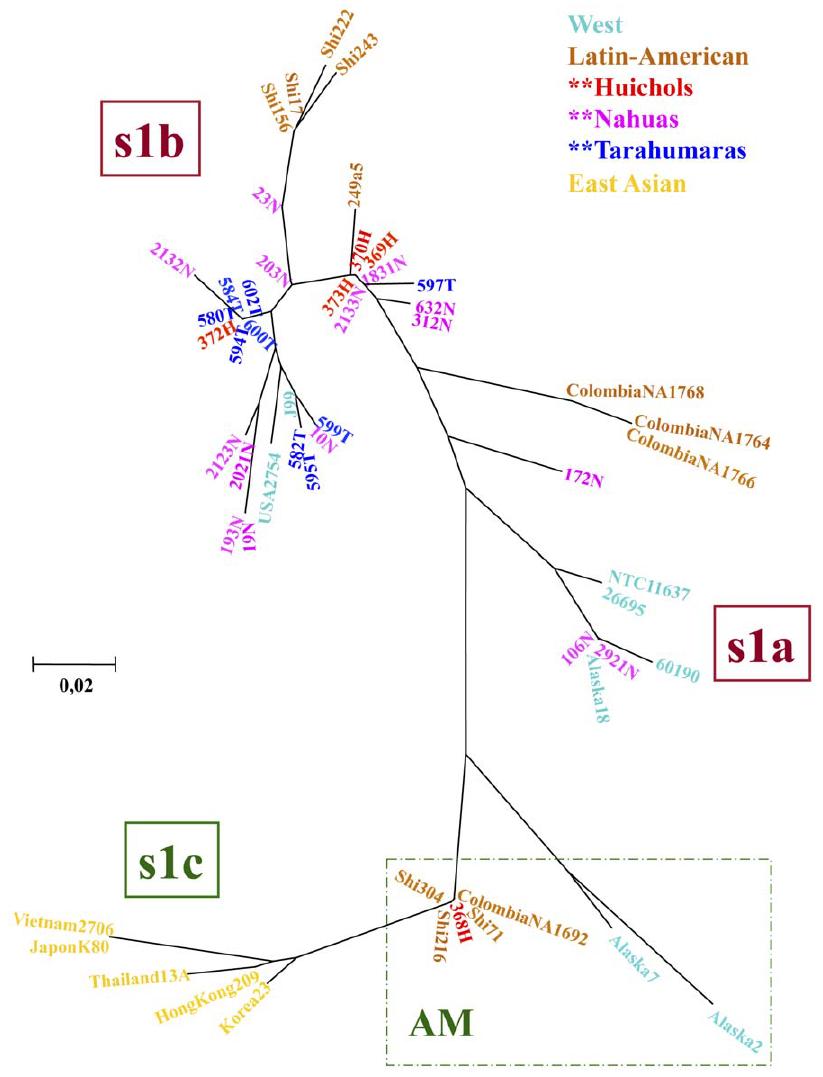
Figure 3. Phylogenetic analysis of sequences of cagA of H.pylori strains from Mexican native groups. The trees were constructed by the Neighbor-joining method based on Kimura’s two-parameter model distance matrices. Phylogenetic analyses of the 3 9 region of cagA shows that whereas most isolates clustered in the Western group (WSS), the Huichol 368H and the Otomi 23O strains grouped closer to the East-Asian group (ESS), together with some Colombian